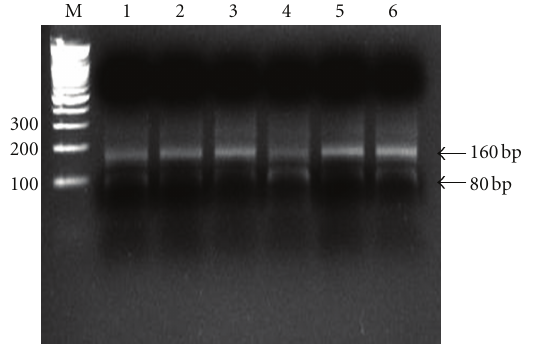
Figure 2: Assessment of LINE-1 hypomethylation status by COBRA LINE-1 method. Calculation was based on the ratio of the digested bands divided by the sum of the digested and undigested bands as described in Materials and Methods section (N: normal; T: tumor).